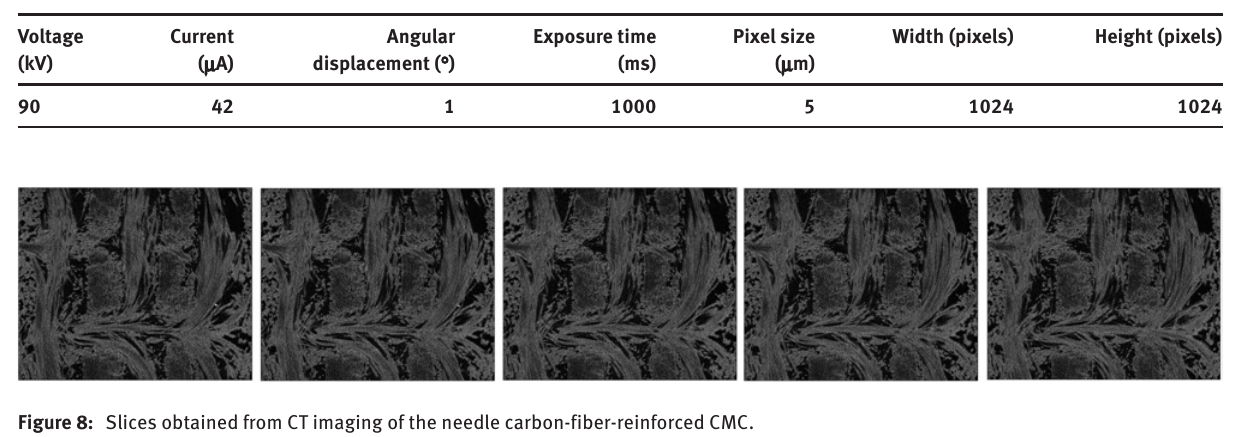
Figure 8: Slices obtained from CT imaging of the needle carbon-fiber-reinforced CMC.